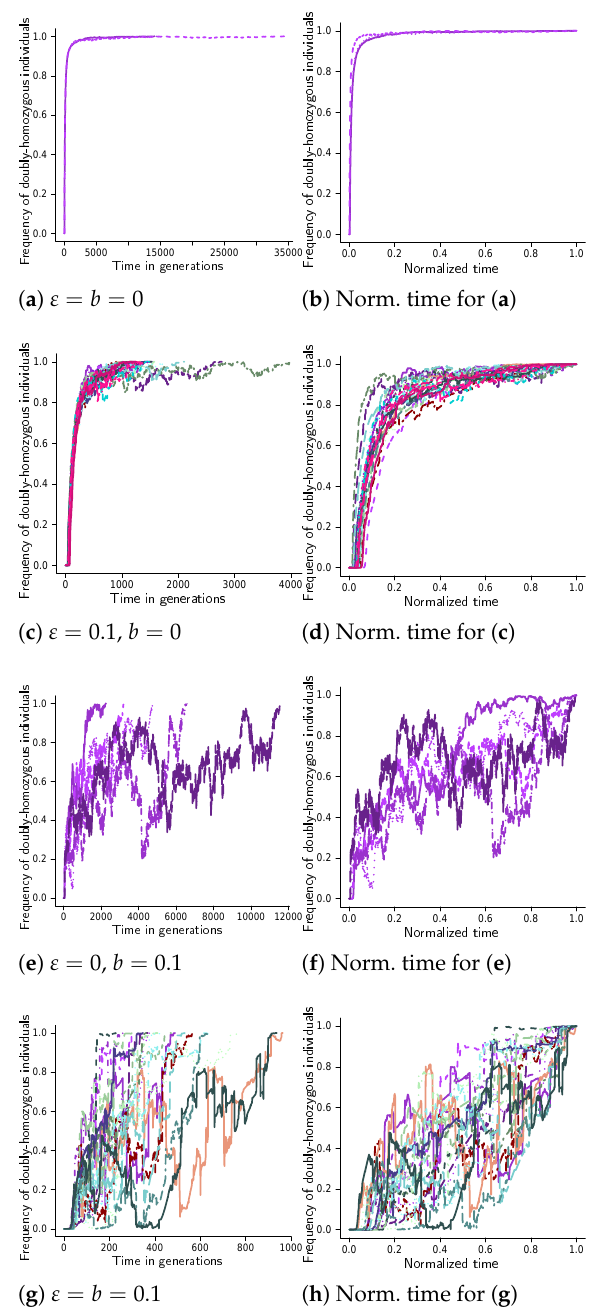
Figure A2. Two sites with weight function as in Equation (A2). Examples of trajectories to fixation at two sites with weight determined by Equation (8) with weight function as in Equation (A2) for carrying capacity C = 10 6 , cutoff u ( N ) = C , probability of recombination r = 0.25 between adjacent sites, α 1 = 0.75, α 2 = 3, ε (see Equation (7)) and probability of a bottleneck b as shown, strength of selection s = 0.1, bottleneck B = 10 3 and results out of ten experiments for ( a ); 10 2 experiments for ( c ); 10 3 experiments for ( e , g ). Each trajectory traces, as a function of time, the number of diploid individuals homozygous for the fit type at all sites relative to the population size (the number of diploid individuals). The panels on the right ( b , d , f , h ) show the corresponding excursions from the left panels ( a , c , e , g ), where the time to fixation for each excursion is normalized by the time to fixation for the excursion. The scale of the abscissa (time axis) may vary between panels. In each panel, all the trajectories were obtained under the same